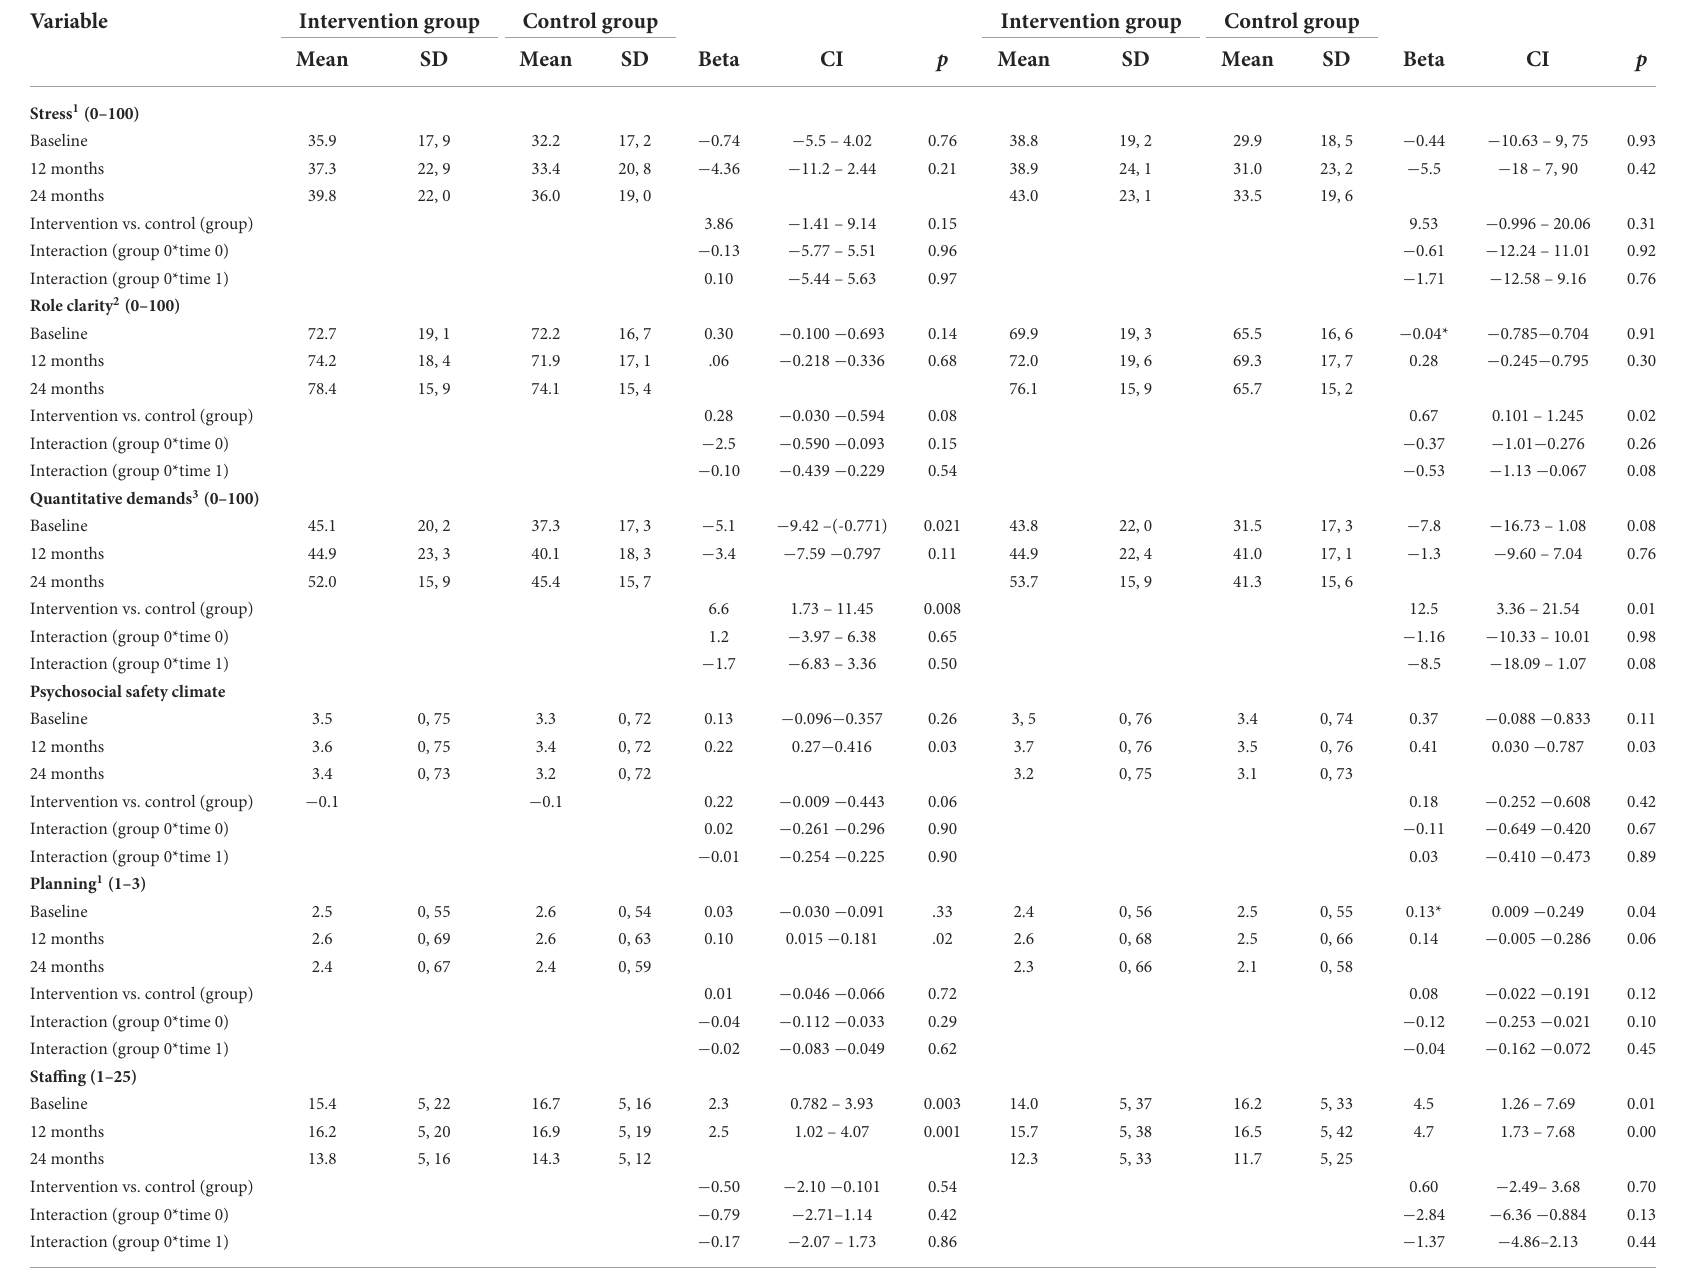
TABLE 3 Adjusted mean values and standard deviations (SD) for professionals and first-line managers at all time points for the intervention and control